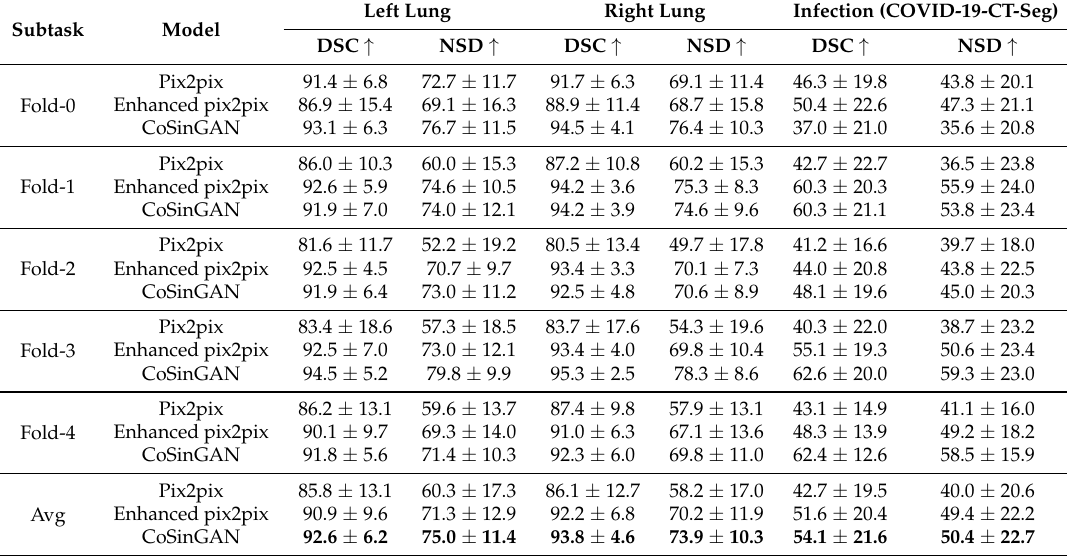
Table 1. Quantitative results (Mean ± Standard deviation) of 5-fold cross validation based on 2D U-Net. For each fold, average DSC and NSD values are reported. The last row shows the average results of 80 (=5 folds × 16 testing cases per fold) testing cases in a COVID-19-CT-Seg dataset. ↑ denotes a higher score and admits better segmentation performance. Our CoSinGAN surpasses the baseline methods by a large margin. The entries in bold highlight the best average